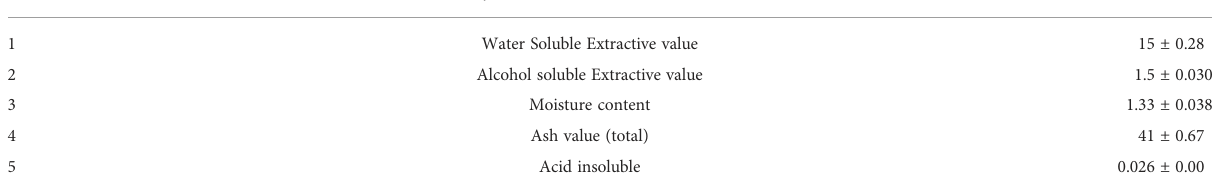
TABLE 1 Physicochemical analysis of Sargassum sp.